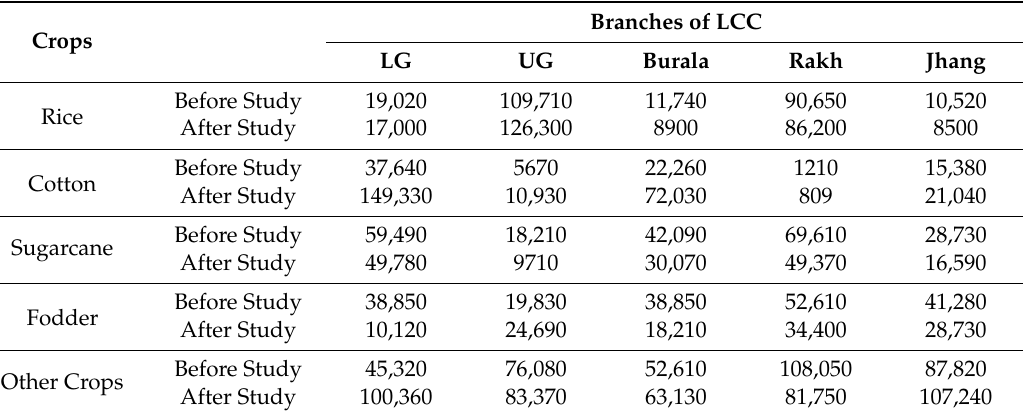
Table 11. Acreage (hectare) of Kharif Crops on branches of the